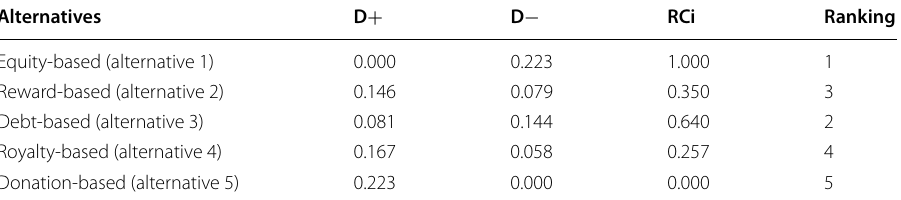
Table 25 Ranking the crowdfunding alternatives for the service development process of clean energy investment projects